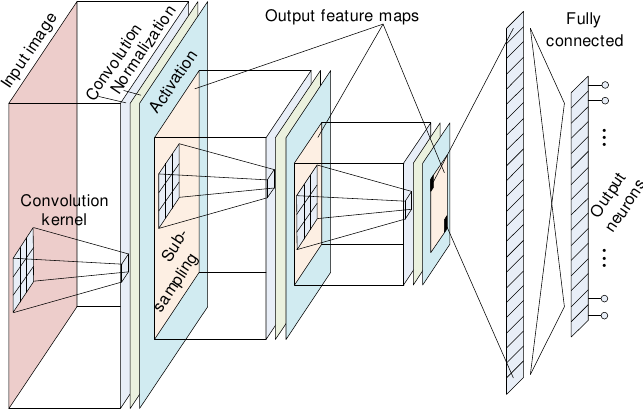
Figure 1. Typical layers in a feed-forward phase of a